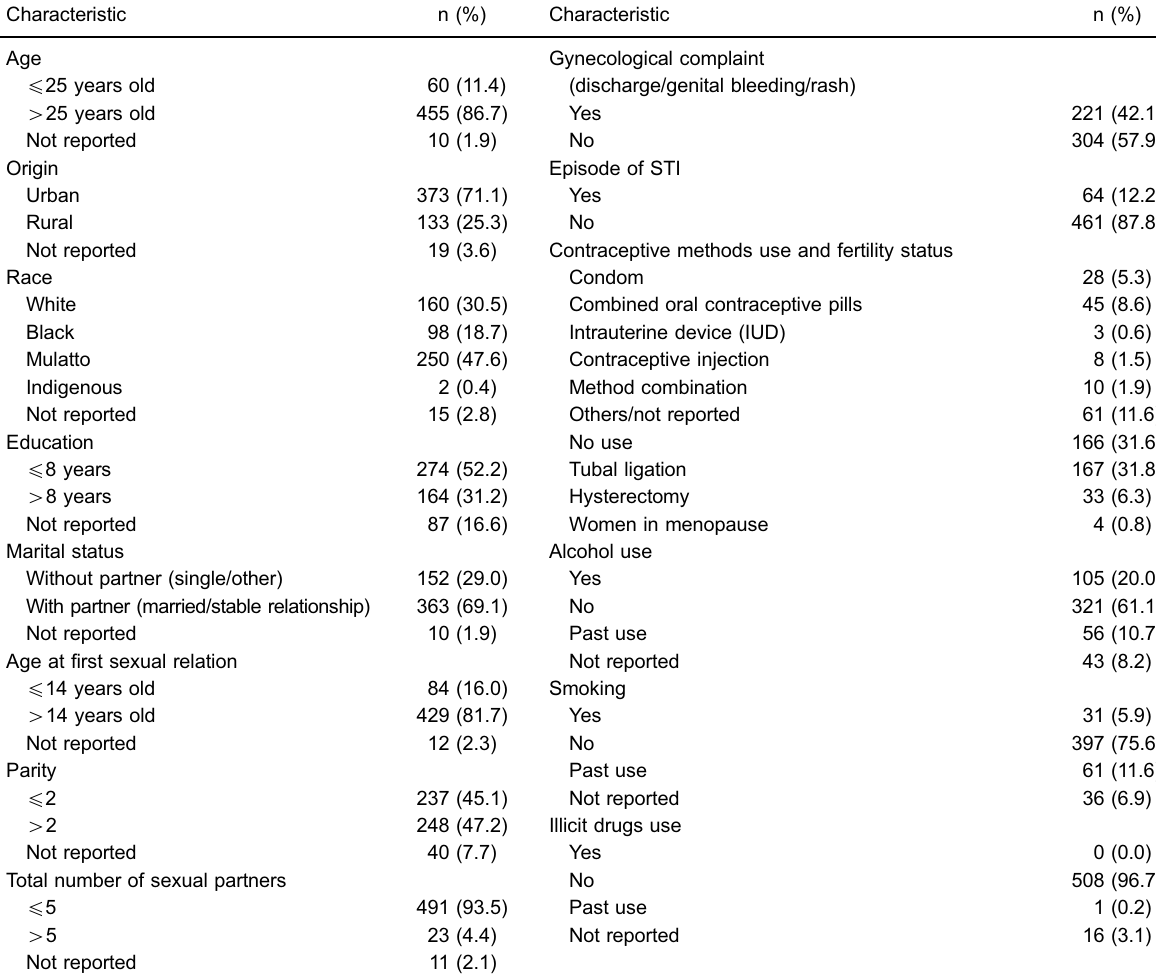
Table 1. Biological, demographic, reproductive, clinical-gynecological characteristics and habits of 525 patients who underwent conventional cytology evaluation and liquid-based ThinPrep evaluation in the State of Pernambuco, 2011.